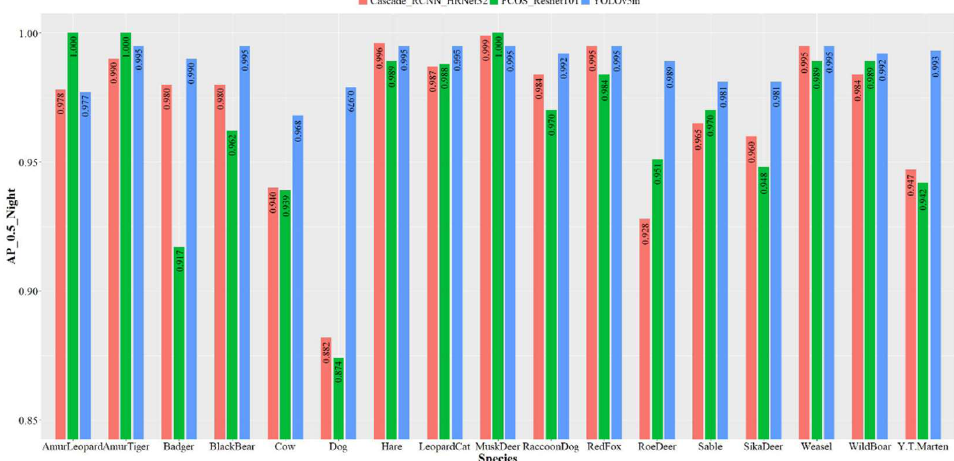
Figure 6. Recognition accuracy of each species of the three object detection models based on the nighttime dataset. The y -axis is the AP value when IOU = 0.5, ranging from 0.85–1; the x -axis is the species.